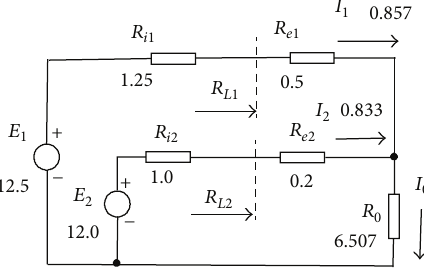
Figure 1: Paralleling of voltage